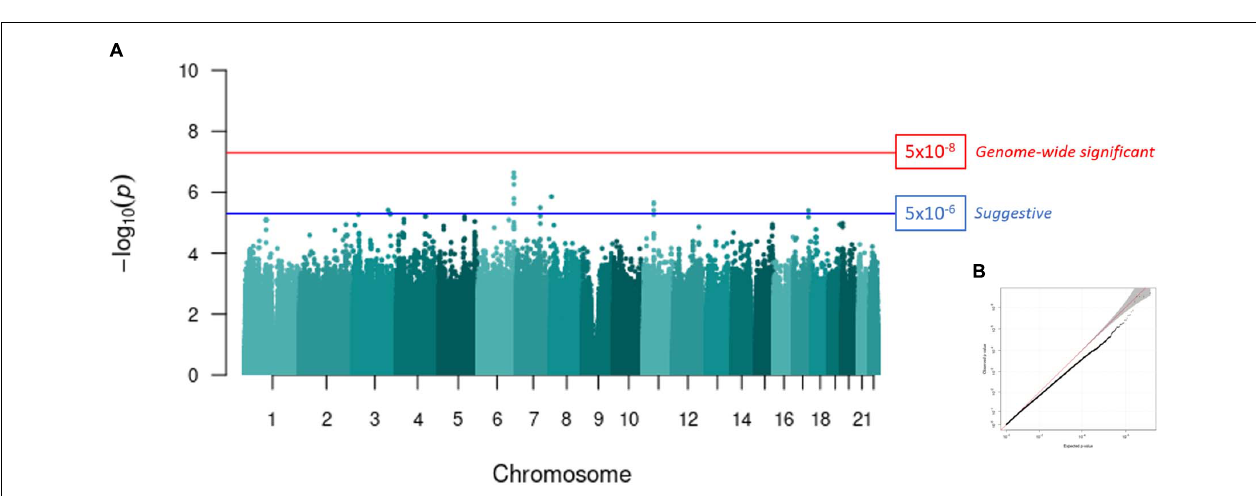
FIGURE 2 | GWAS meta-analysis of PTSD in a South African cohort. (A) A Manhattan plot representing the GWAS meta-analysis (controls, n = 343; PTSD cases, n = 260) of Wave 1 and Wave 2. The red line indicates the genome-wide significance threshold after Bonferroni correction ( p < 5 × 10 − 8 ) and the blue line represents a suggestive significance threshold ( p < 5 × 10 − 6 ). Seven independent loci reached a suggestive level of genome-wide significance. SNP rs2315551 on chromosome six had the smallest p -value ( p = 2.262 × 10 − 7 ). (B) A Q-Q plot of the expected vs. observed p -values obtained from the meta-analysis illustrates the absence of confounding population structure (genomic inflation, λ =